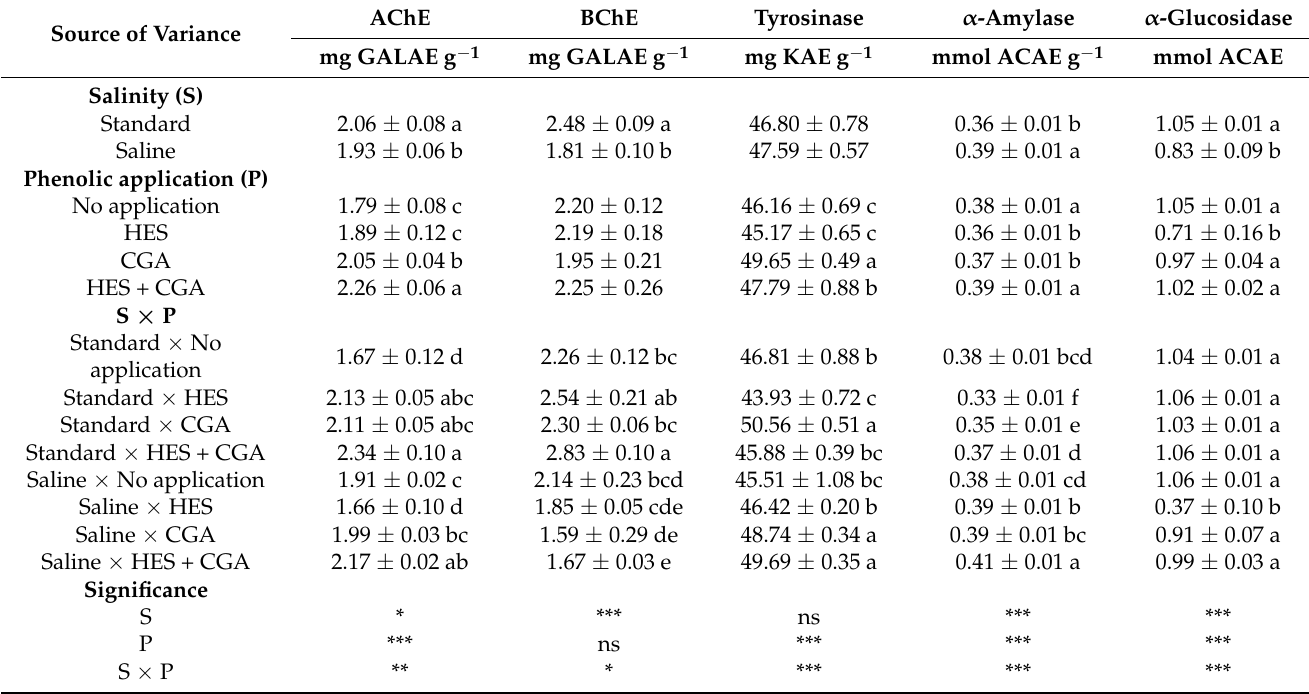
S × P Values are reported as mean ± standard deviation of three parallel experiments. The symbols ns, *, **, *** indicate non-significant or significant at p < 0.05, 0.01, and 0.001, respectively. Different letters within each column indicate significant differences according to Duncan’s multiple-range test ( p < 0.05). The Salinity factor was compared with the independent Student’s t -test. GALAE: galantamine equivalent; KAE: kojic acid equivalent; ACAE: acarbose